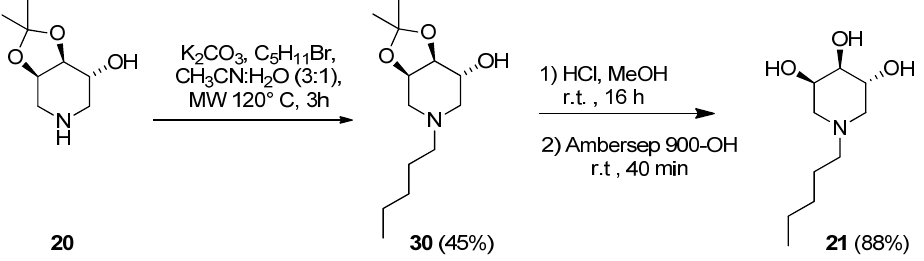
Figure 4. The two possible chair conformations of piperidines 11 and 13 . Dihedral angles between bonds analysed for the determination of the preferred conformation are shown in blue. Red double- ended arrows show the observed diagnostic NOE correlation peaks in the 1D-NOESY NMR spectra. 1 H-NMR chemical shifts of selected signals are reported, with the corresponding coupling constants in parenthesis (in Hz).